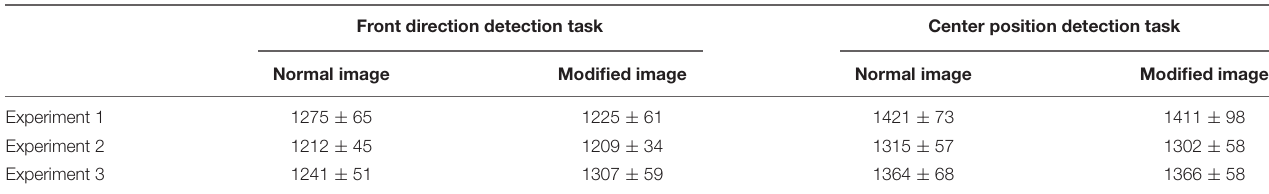
TABLE 1 | Summary of Reaction Times (ms) in the experiments (Mean ±